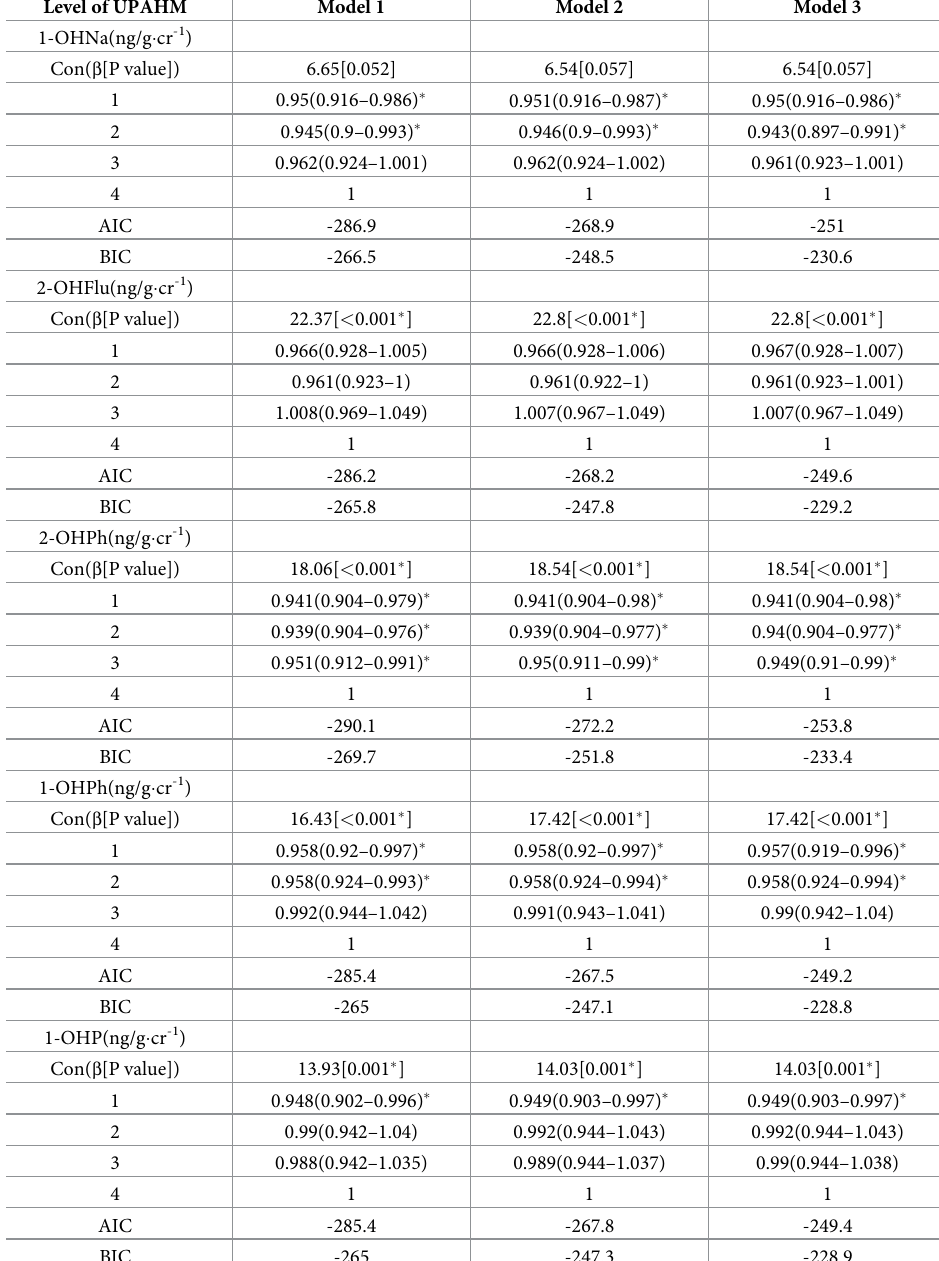
Table 3. Dose-reposed effect of PAH exposure on